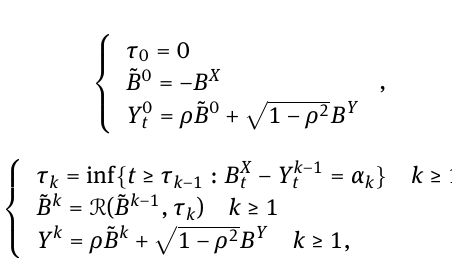
Figure 3: One trajectory of X, Y and X − Y in the multi-barrier correlation model with ν = 0 , η = 0.5 , ρ = 0.9 . (cid:16) ˜ Let B k